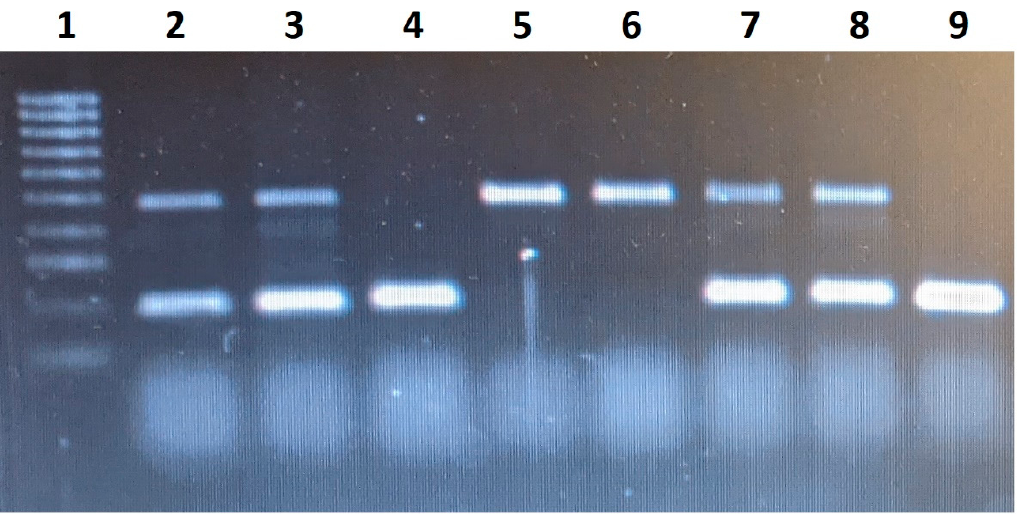
Figure 1. Visualization of ACE gene fragments after gel electrophoresis. Fragments are separated in vertical lanes; each lane represents fragments from one proband. Line 1 contains 100 bp ladder. Lanes 2, 3, 7 and 8 contain I and D fragments (visible shorter and longer bands), i.e., probands have a heterozygous ID genotype. In lanes 4 and 9, there is only a shorter fragment, i.e., probands have a homozygous genotype for allele D. In lanes 5 and 6, there are longer fragments, i.e., these probands are homozygous for the I allele.